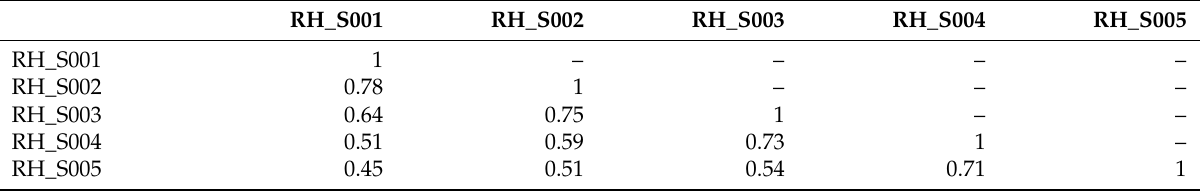
Table 1: Spearman correlation between taxonomic profiles a of CAMI metagenomes.